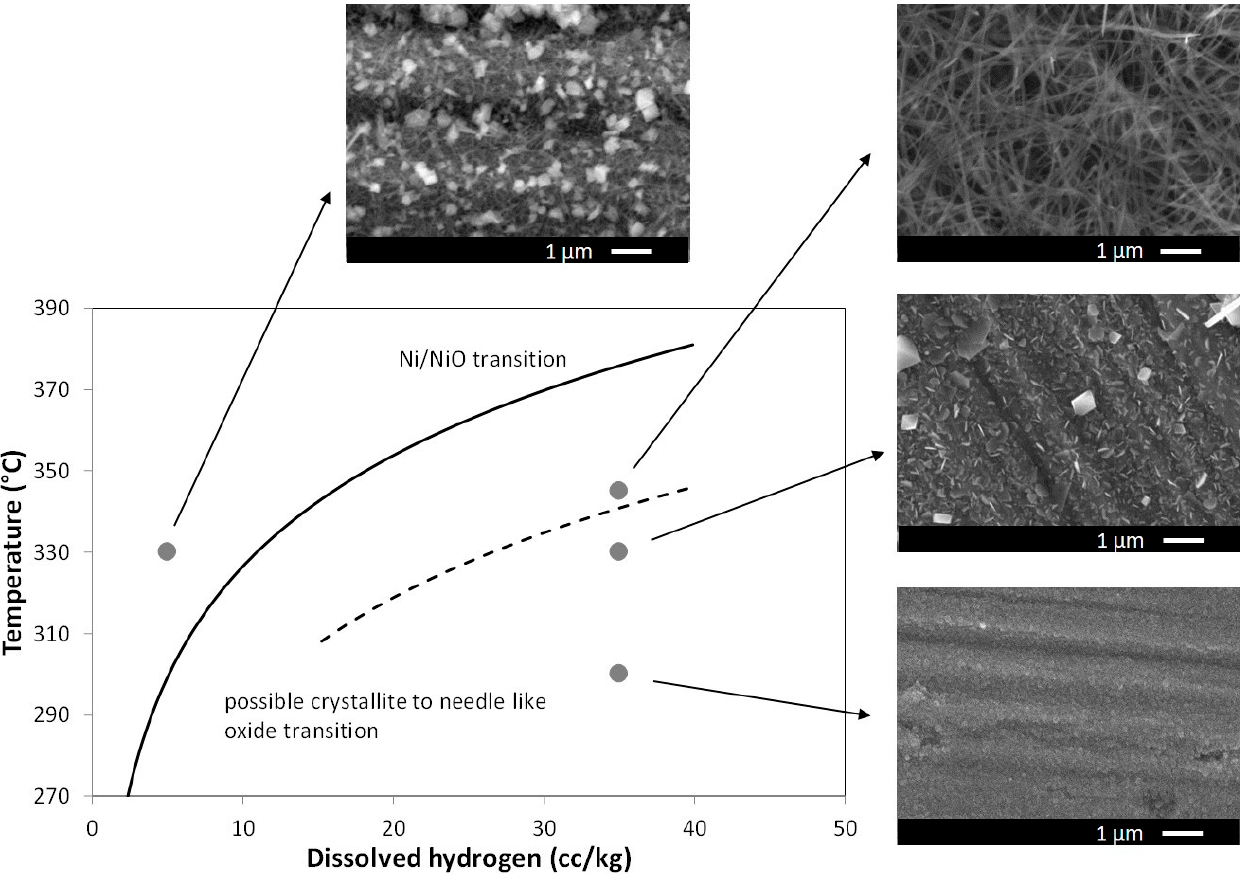
Figure 1. The nickel–nickel oxide transition curve as a function of temperature and dissolved hydrogen concentration showing the selected test conditions for the EIS measurements and related surface morphology. Solid line data from Andresen [3]; dashed line data from Terachi [6].